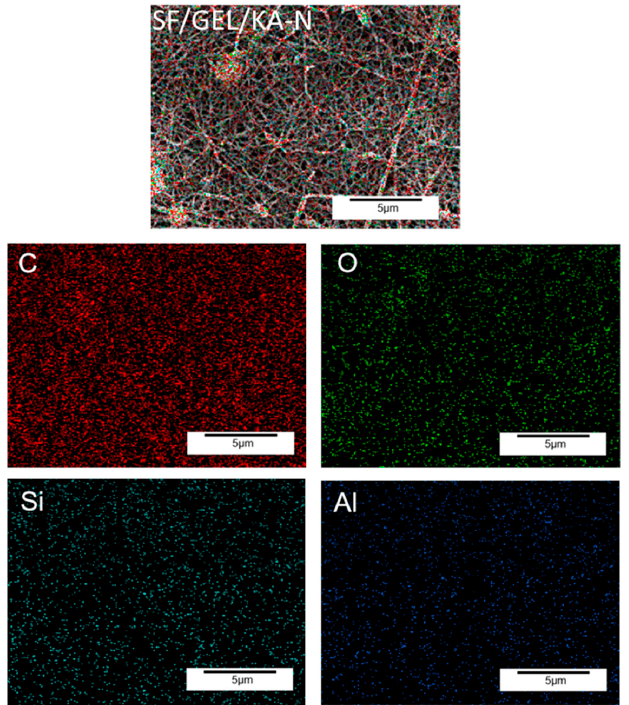
Figure 3. Elemental distribution diagram of carbon, oxygen, silicon, and aluminum in the SF/GEL/KA-N porous fi ber fi lm.